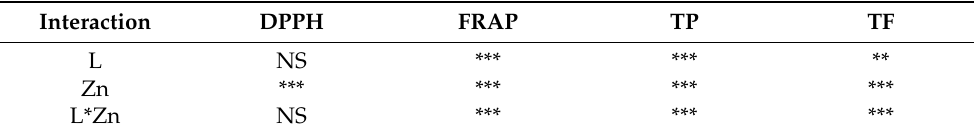
The interaction effects of DPPH (radical inhibition percentage of 1,1-diphenyl-2- picrylhydrazyl), FRAP (ferric ion-reducing antioxidant power), TP (total phenolic compounds) and TF (total flavonoid) in flowering Chinese cabbage sprouts (FCCS). Interaction